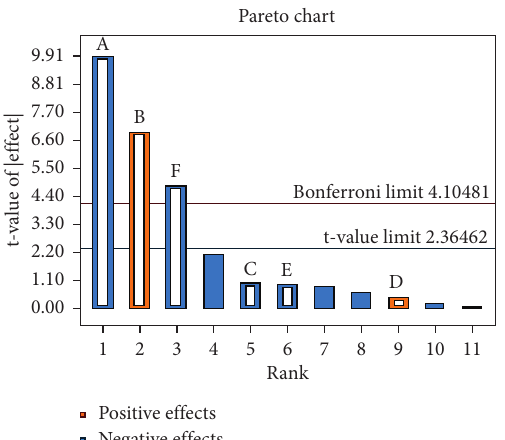
Figure 2: Pareto chart of the Plackett–Burman design for the FTP yield. (A) Potato extract, (B) glucose, (C) KH V b 1 , and (F)